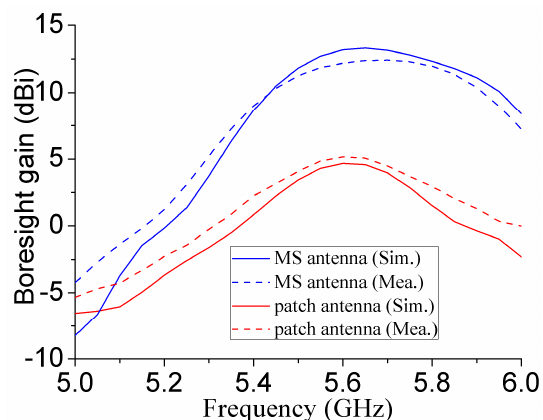
Figure 11. Simulated and measured boresight gains for patch antenna and MS antenna.